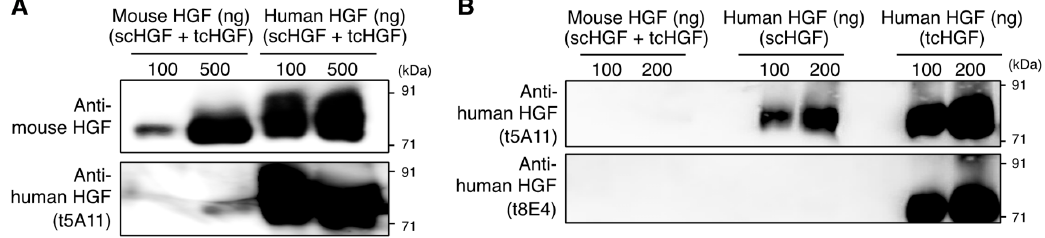
Figure 1. Specificity of anti-human HGF antibodies. ( A ) Western blot analysis for the cross-reactivity of anti-mouse HGF polyclonal antibody and t5A11 anti-human HGF monoclonal antibody between mouse and human HGF. ( B ) Specificity of anti-HGF monoclonal antibodies (t5A11 and t8E4) to mouse HGF, scHGF, and tcHGF. Mouse HGF and human HGF were subjected to SDS-PAGE under non-reducing conditions. Human HGF (composed of scHGF and tcHGF), scHGF, and tcHGF were expressed and purified as described in the Materials and Methods section.